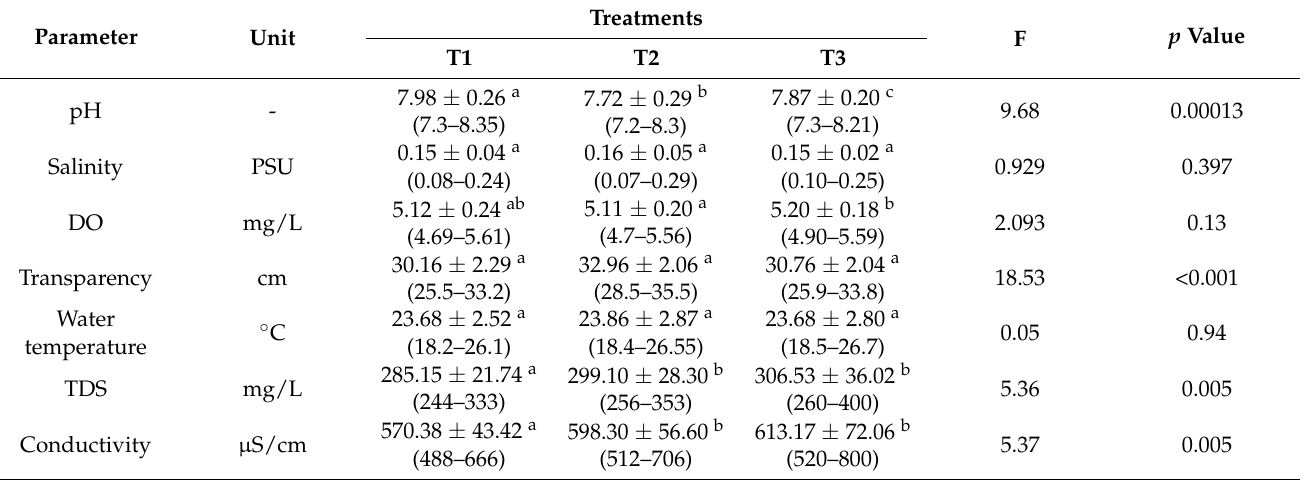
Table 1. Descriptive statistics of water quality parameters observed in the three different treatments (mean ± SD; range in parentheses).